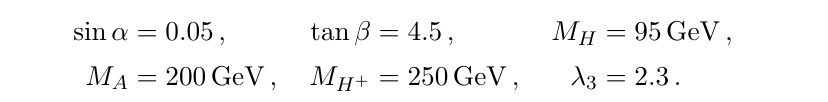
p s = 13 TeV falls into the range of